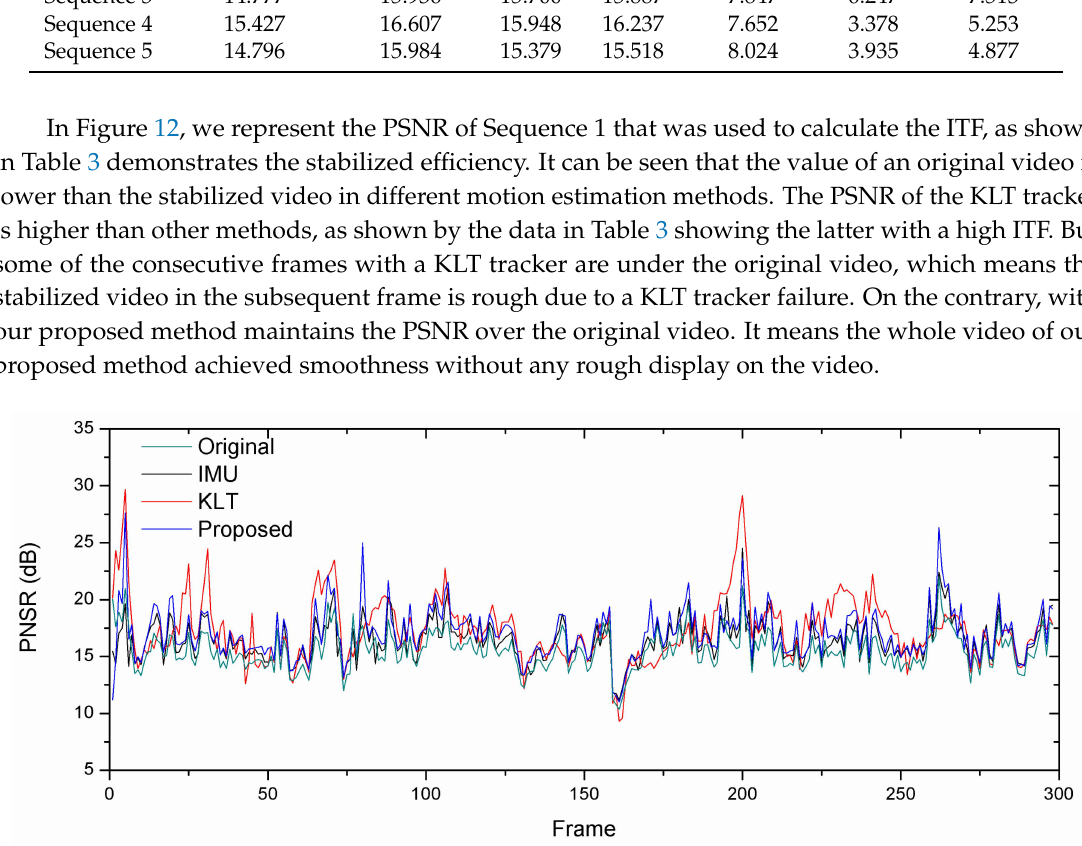
Figure 12. Comparison of PSNR with a different motion